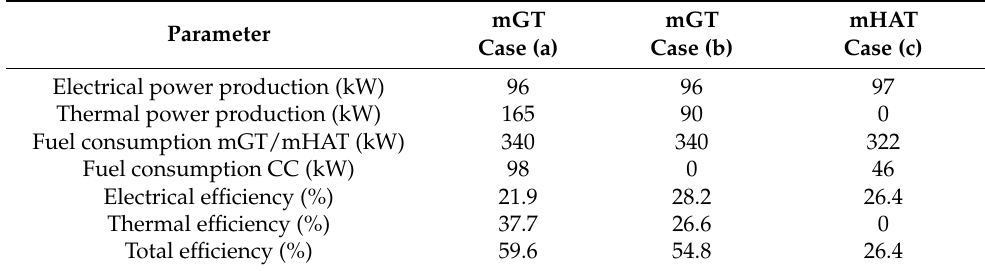
Table 10. Efficiencies of plant layouts (adapted from